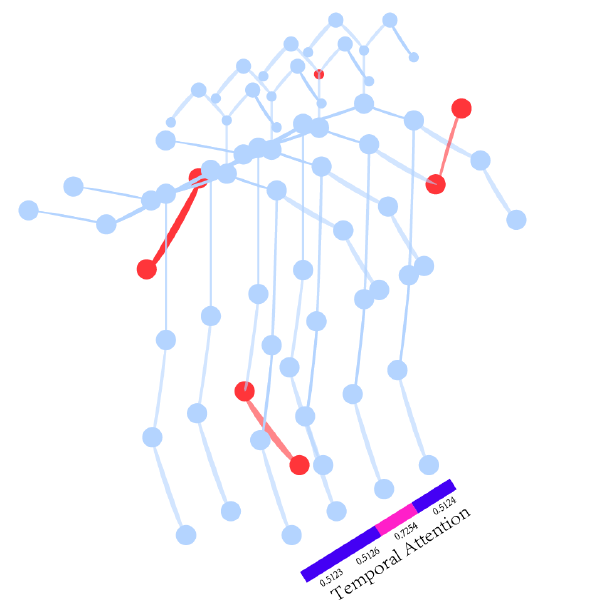
Figure 1. Topology-embedded temporal attention. Different-colored bars represent the responses of the topology relationships of the skeleton data on each frame in the time dimension. Thus, the final feature is more distinct for